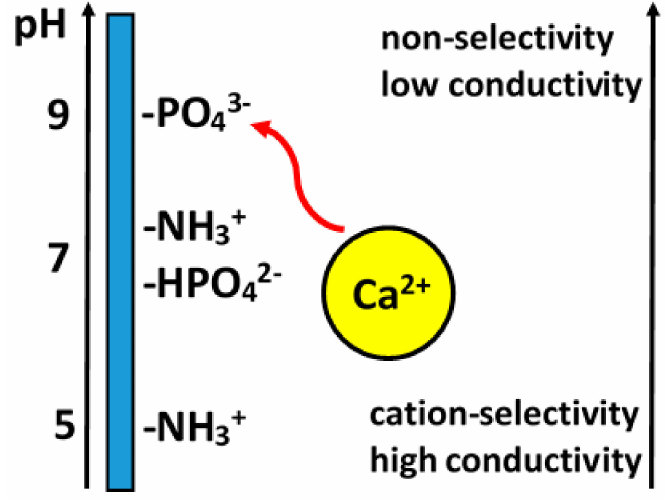
Figure 9. Schematic illustration of PET membrane modifying by O-Phospho- l -Tyr (OPLT) with functional groups according to Xu et al. [369]. System shows “smart” selective ion transport depending on pH